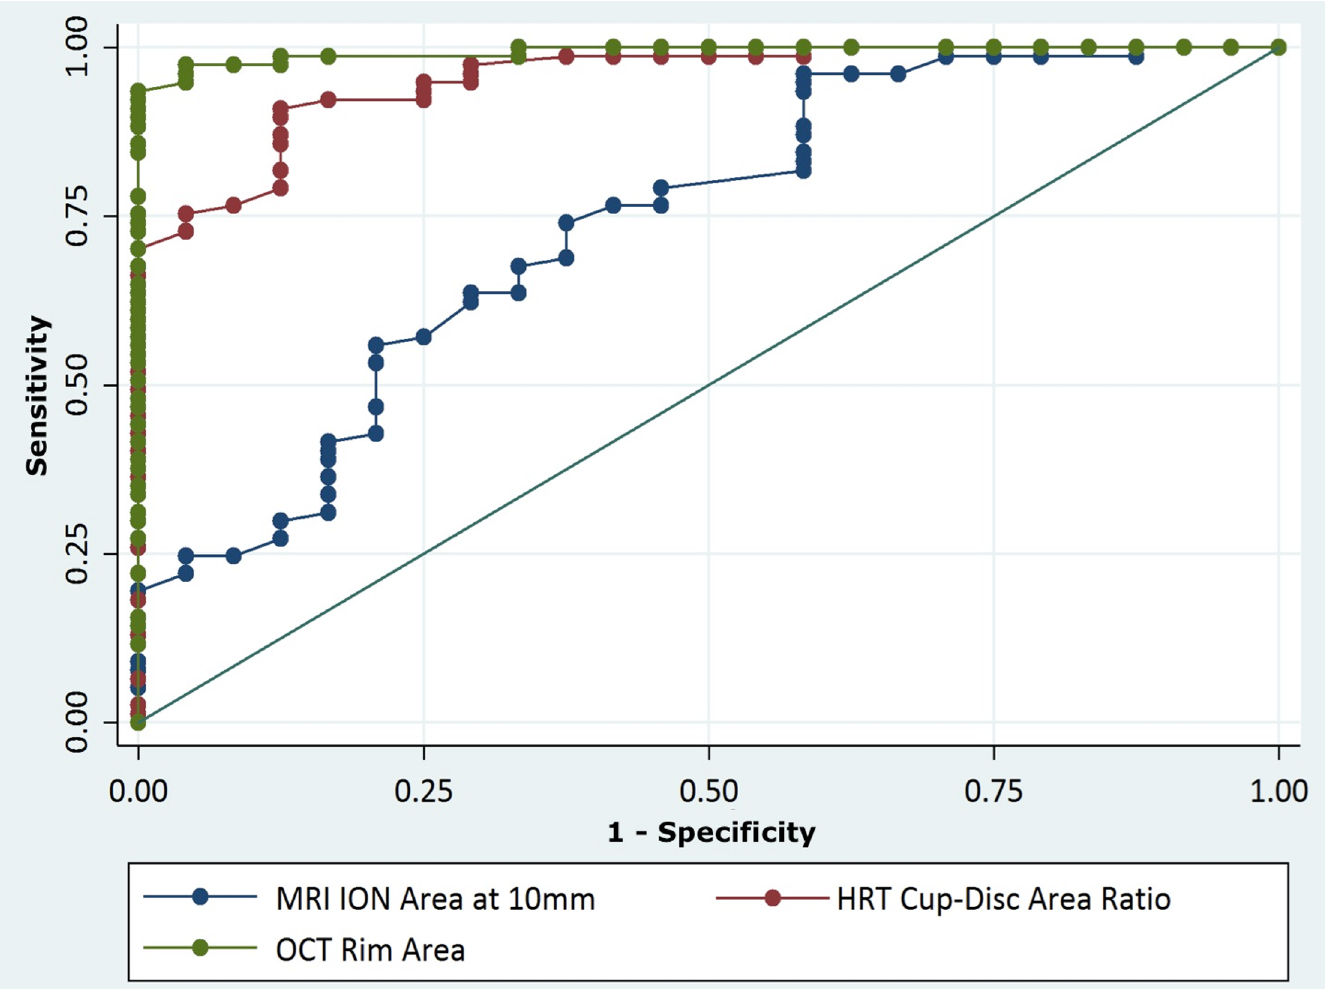
Fig 3. Receiver operating characteristic curves for the best-performing parameters of the different devices used in the study to discriminate glaucomatous from healthy eyes. MRI = magnetic resonance imaging; ION = intraorbital optic nerve; HRT = confocal scanning laser ophthalmoscopy;OCT = spectral-domain optical coherence